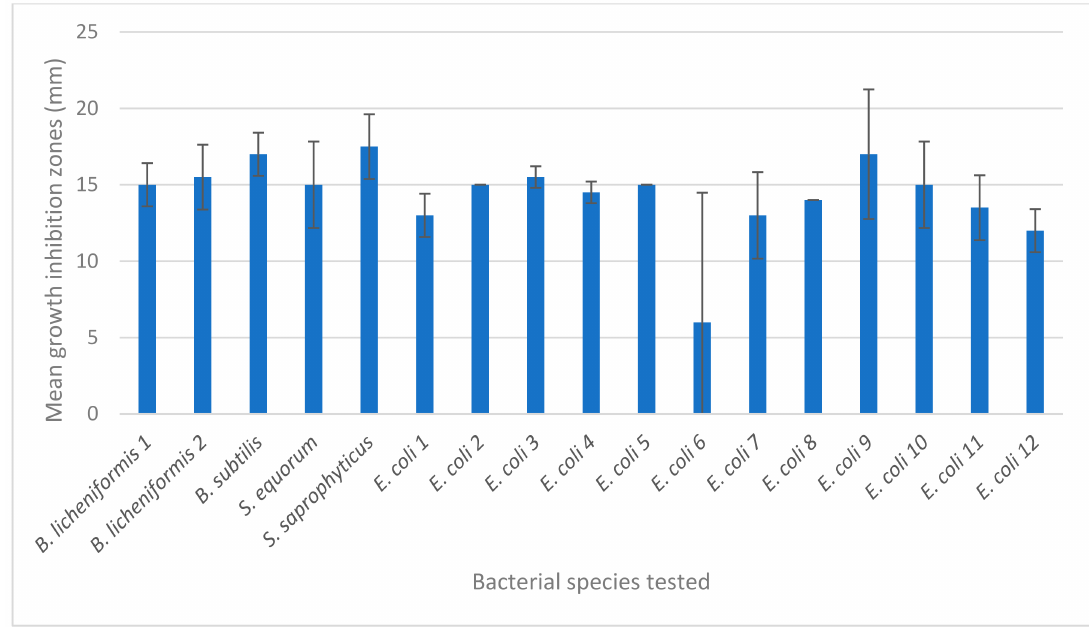
Figure 4. Mean growth inhibition zones (mm) caused by Hyal/Ag and Hyal/Ag/GO silver nanoparticle composites. The antimicrobial activity of silver has been attributed to certain morphological and physicochemical characteristics, including size, shape, colloidal stabilization, sur- face corona, composition, aggregation behavior, surface coating, surface/volume ratio, etc., which—when properly used—contribute to the inhibitory potential against several pathogenic microorganisms [50]. The antimicrobial (both antifungal and antibacterial) activity of silver nanoparticles synthesized using a number of various approaches has